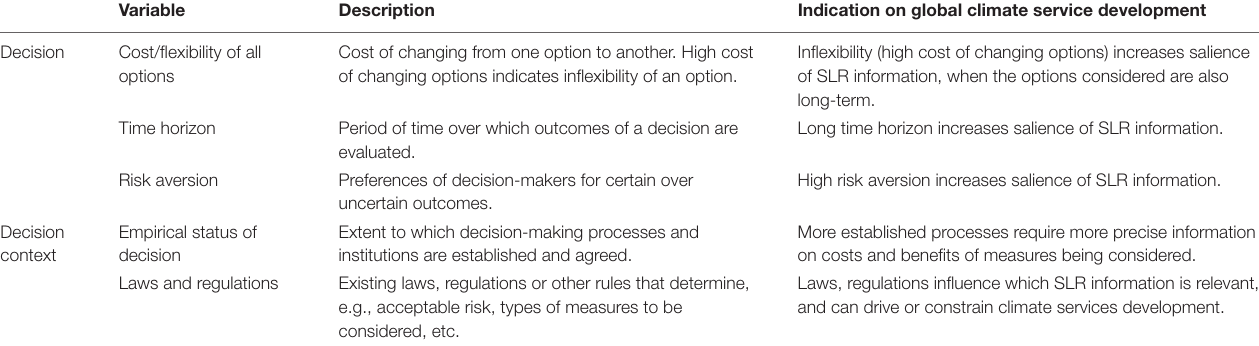
TABLE 1 | Decision and decision context variables. Variable